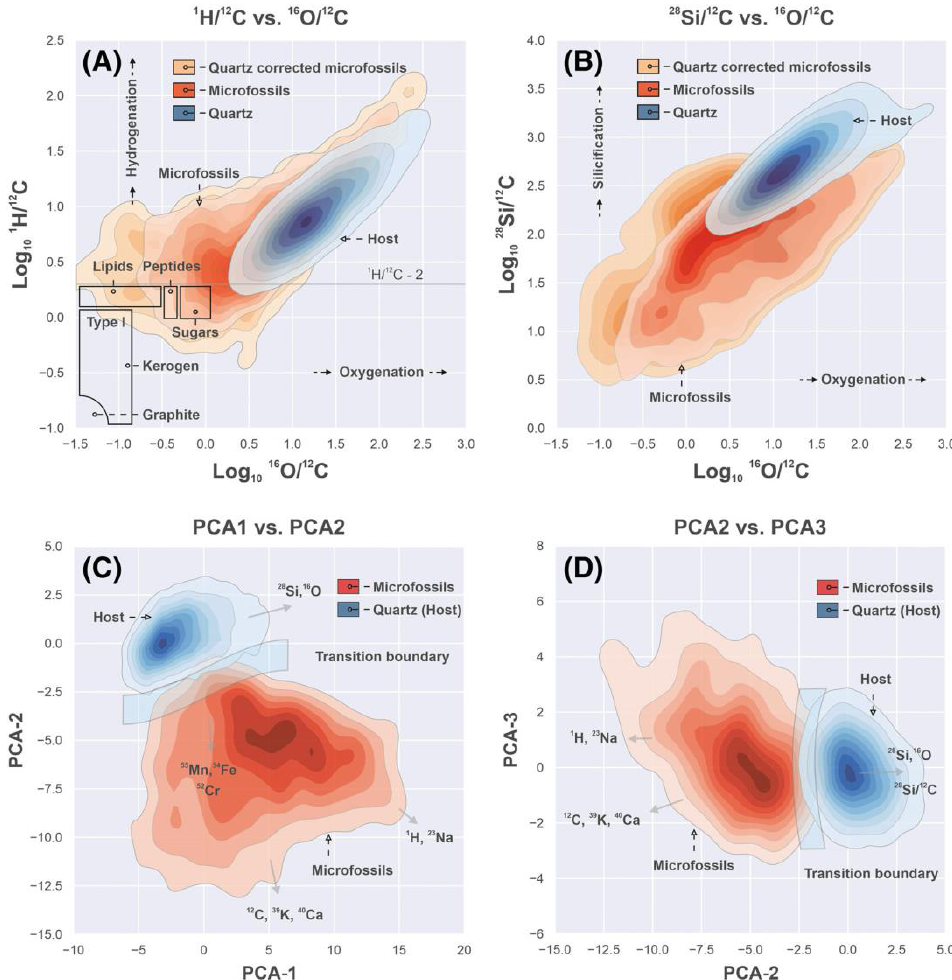
Figure 6. The mass spectrometric data can be separated into the data characterising mineralogical host phase and fossilised entities with their specific chemical compositions. ( A , B ): Kernel density estimates (KDE) of 1 H/ 12 C and 28 Si/ 12 C as function of 16 O/ 12 C ratios, respectively (Van Krevelen plots). Blue and red kernels represent values measured from the host and microscopic fossilised areas, respectively. ( C , D ): 2D projections of the 196 features into the principal components space. Arrows represent loading directions for different single unit masses. The blue transparent line indicates the location of the transition boundary between two classes. (Reproduced with the permission from